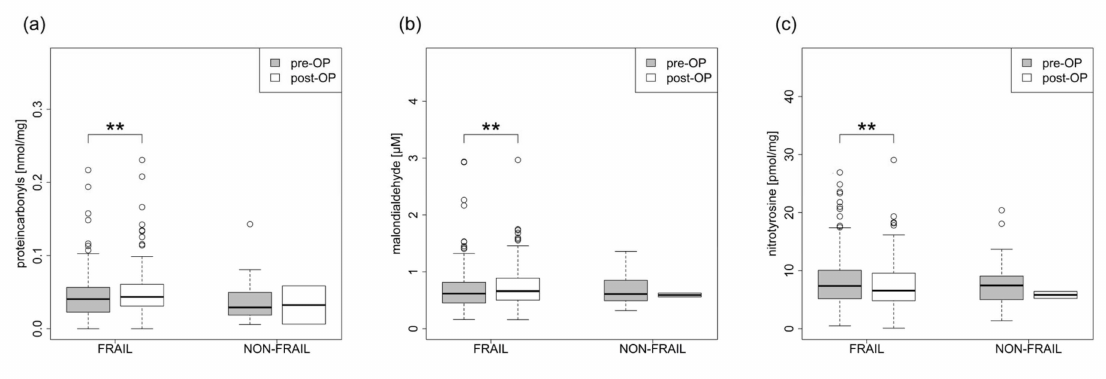
Figure 3. ( a – c ) Plasma redox biomarkers. ** p < 0.01.